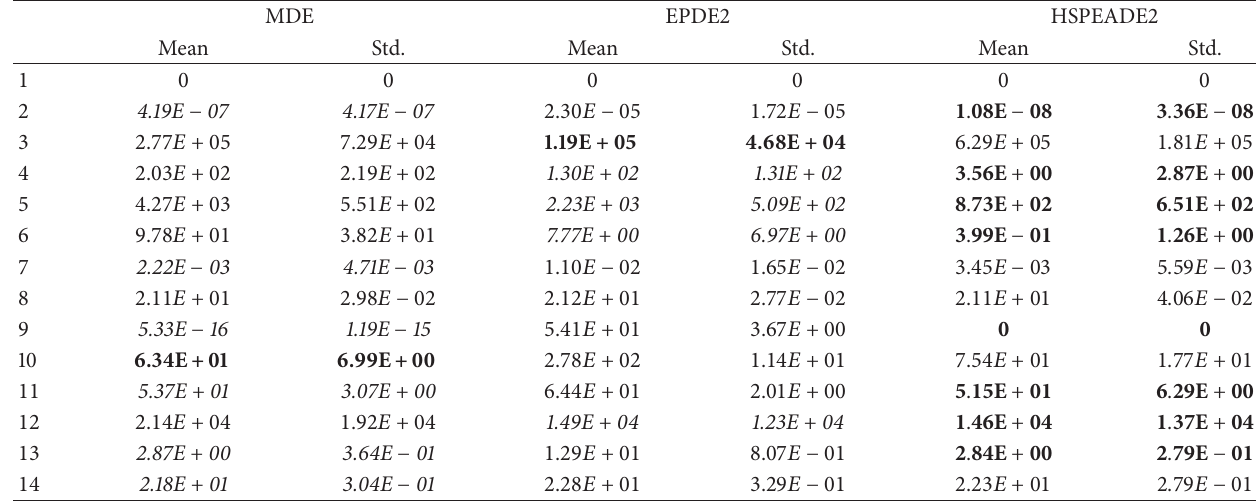
Table 5: Performance of MDE, EPDE2, and HSEPDE2 on 50D problems.